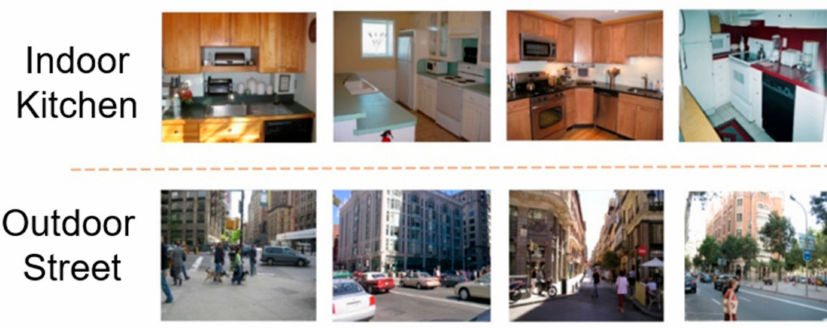
Figure 6. Several indoor and outdoor examples from the Scene 30